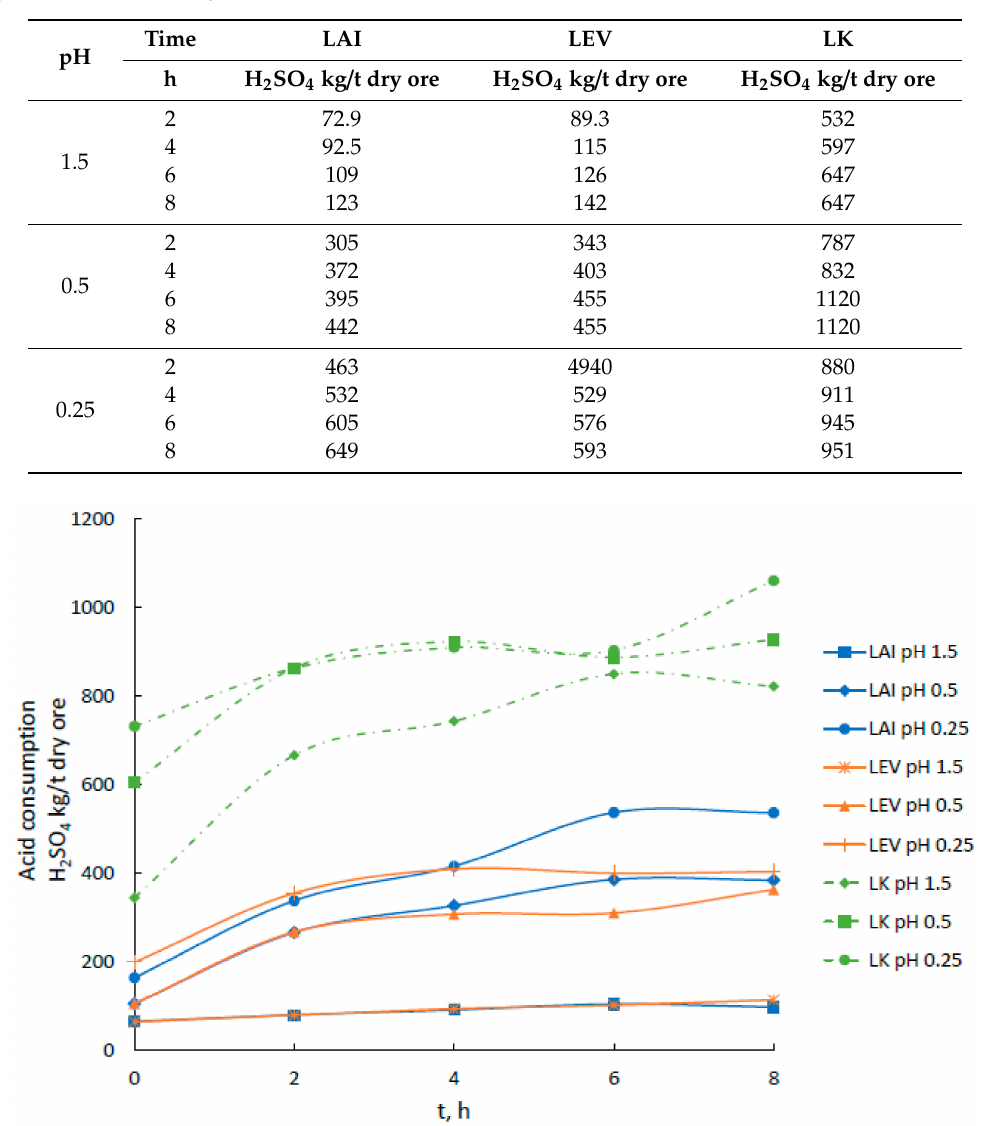
Table 5. Cumulative acid additions (H 2 SO 4 kg / t dry ore) during leaching of the LAI, LEV, and LK laterites in pH 0.25, 0.5, and 1.5. Parameters used in the experiments: 90 ◦ C, S / L = 30%, 800 rpm. pH was maintained by H 2 SO 4 addition.